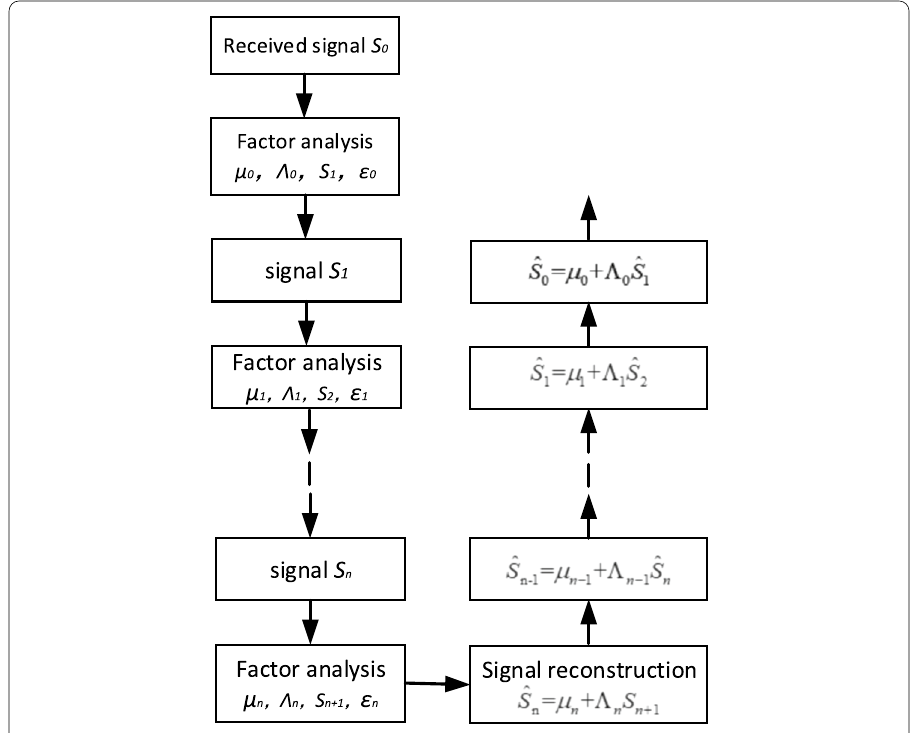
Fig. 7 Deep factor analysis